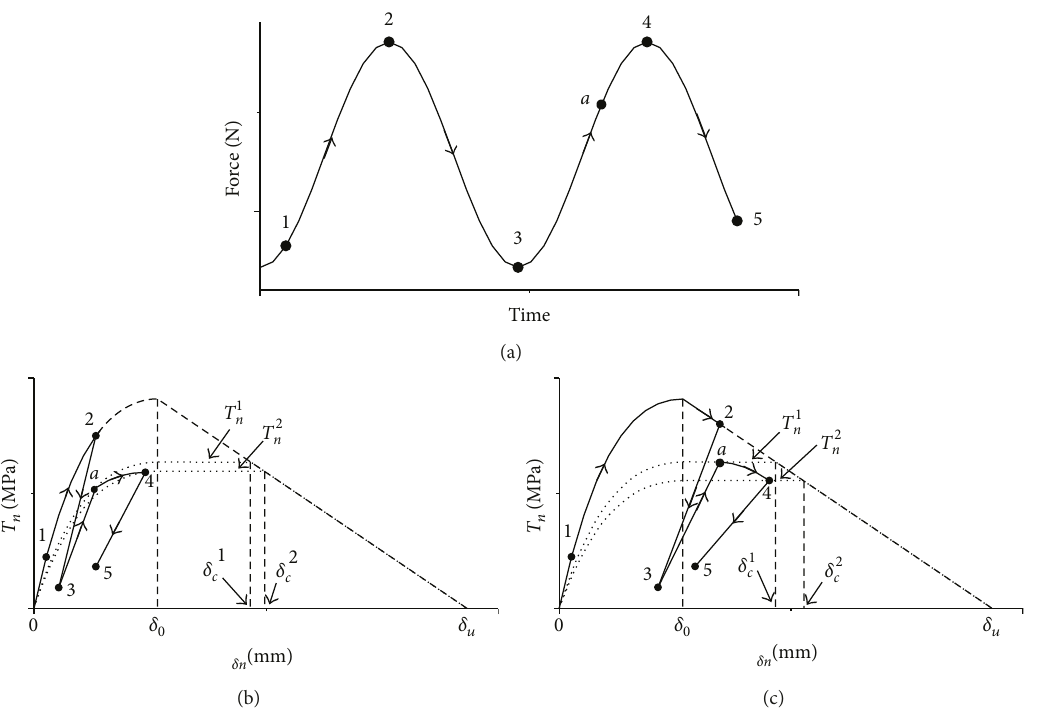
< δ fi rst half cycle) and n 0 (